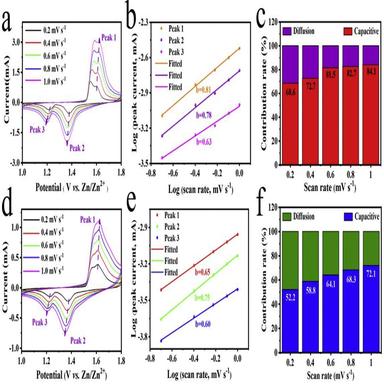
(a) Nyquist plots for the ZnMn2O4 NDs/rGO composite and pure ZnMn2O4 microspheres. (b) Relation of Z′–ω−1/2 curves in the low-frequency region for the ZnMn2O4 NDs/rGO and pure ZnMn2O4 microsphere. (c) GITT curves and (d) calculated Zn2+ diffusion coefficient of ZnMn2O4 NDs/rGO and pure ZnMn2O4 microsphere electrodes during the discharge process. (e) Schematic illustration of electrochemical performance of the strongly coupled ZnMn2O4 NDs/rGO composite.